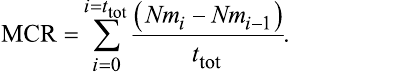
Figure 9b shows the MCR of molecules as a function of ε r . For values of ε r below a certain threshold, the MCR increases in proportion to ε r . The movement of molecules in the